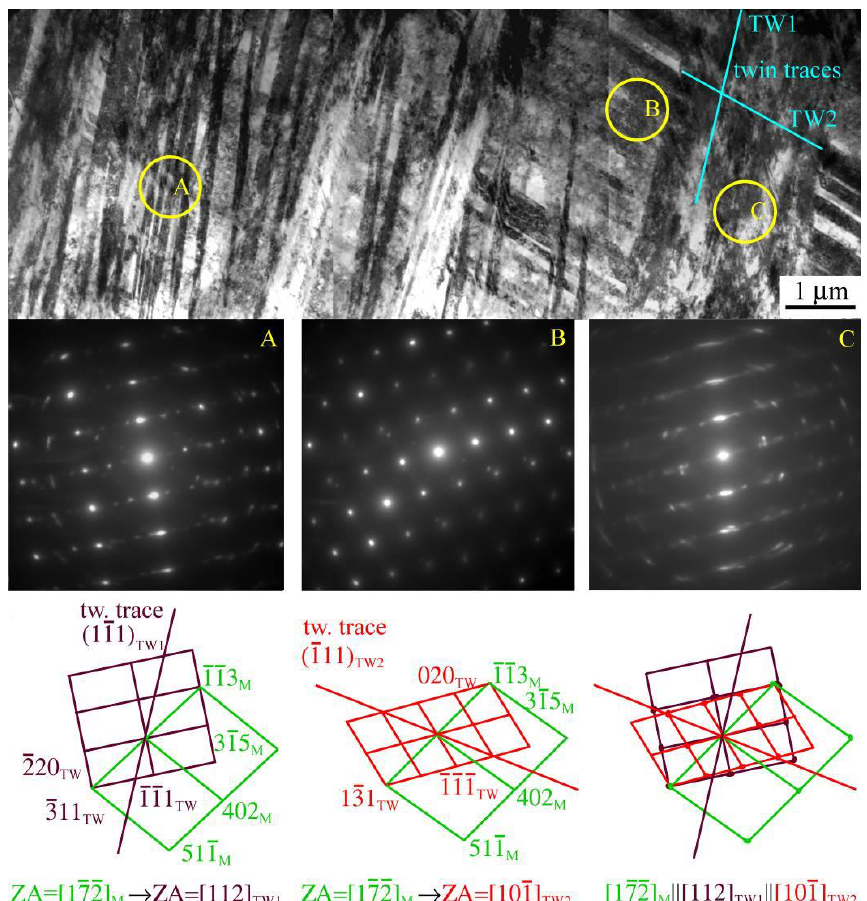
Figure 1. Transmission electron microscopy (TEM) bright-field image of microstructure, selected area electron di ff raction (SAED) patterns and their interpretations for high-pressure torsion (HPT) 23 -processed specimens of the Fe-13Mn-1.3C steel. Areas corresponded to the SAED patterns ( A – C ) are marked in yellow circles on TEM image. Zone axes (ZA) of the matrix (M) austenitic phase and twin (TW) variants are shown below SAED patterns. SAED patterns probed areas are 1.4 µ m 2 .